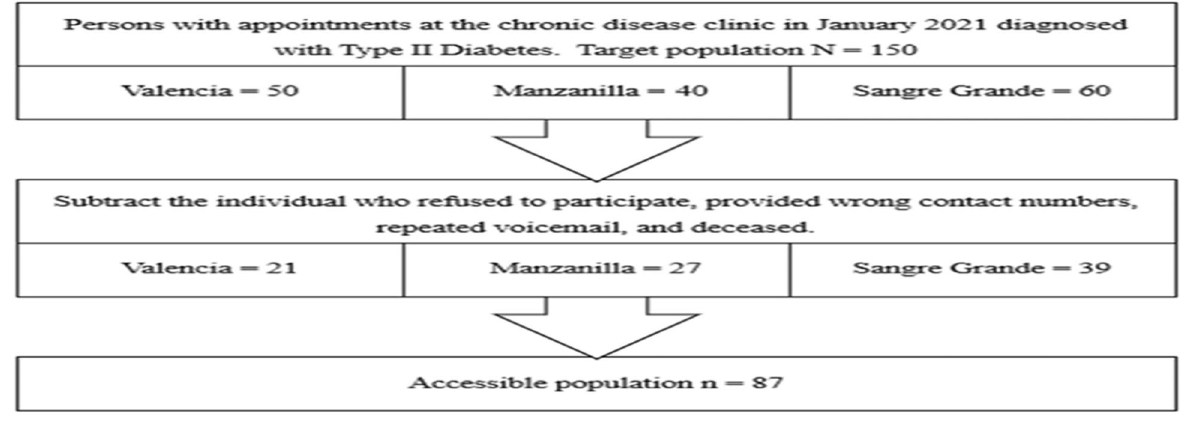
Fig. 3 Segmented process of obtaining the sample